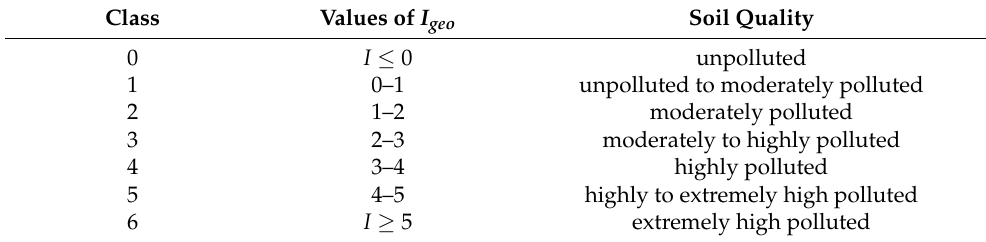
Table 4. Division of class for Geo-accumulation index according to Muller, 1979 [57]. Class Values of I geo Soil Quality 0 I ≤ 0 unpolluted 0–1 unpolluted to moderately